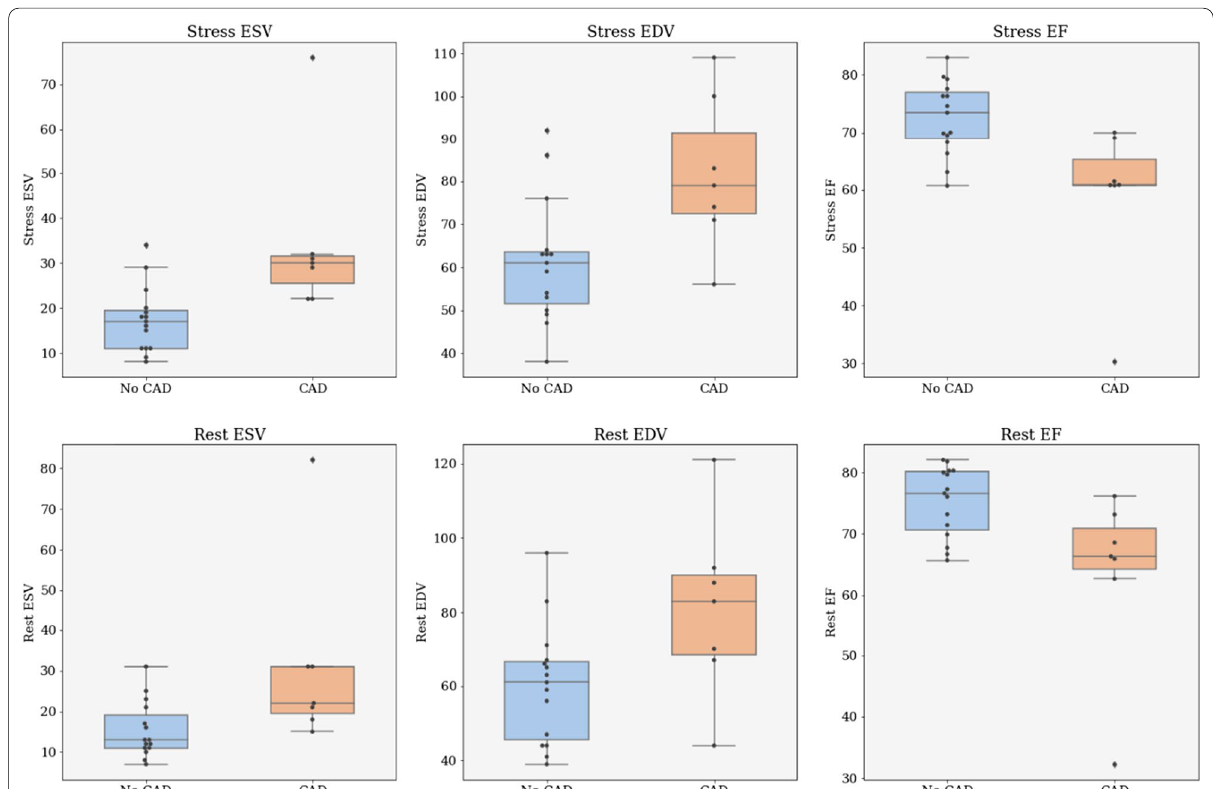
Fig. 1 Comparison of stress ESV, stress EDV, stress EF, rest ESV, rest EDV and rest EF in patients with and without